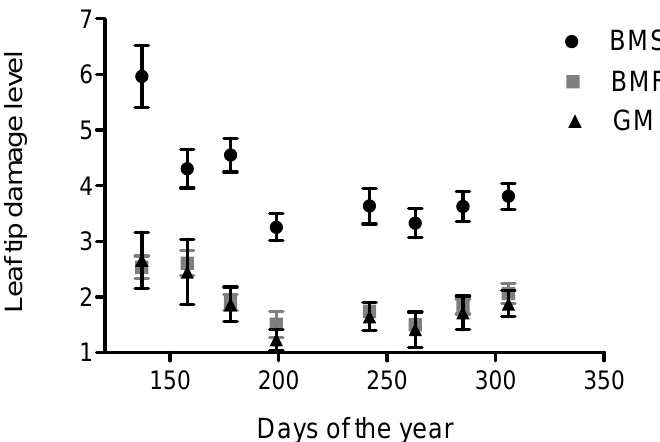
Figure 6. Mowing system effect on tall fescue leaf tip damage level (Equation (1)) on 17 May, 7 June, 27 June, 18 July, 30 August, 20 September, 12 October and 2 November. BMS = battery-powered mower revving at 3000 rpm, BMF = battery-powered mower revving at 5000 rpm and GM = gasoline-powered mower. Letters “a” and “b” indicate statistically different values at p < 0.05 for each assessment date.